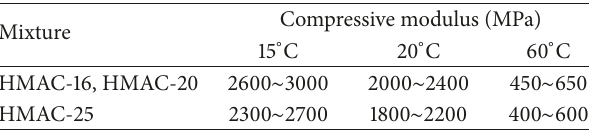
Table 6: Technical index of static